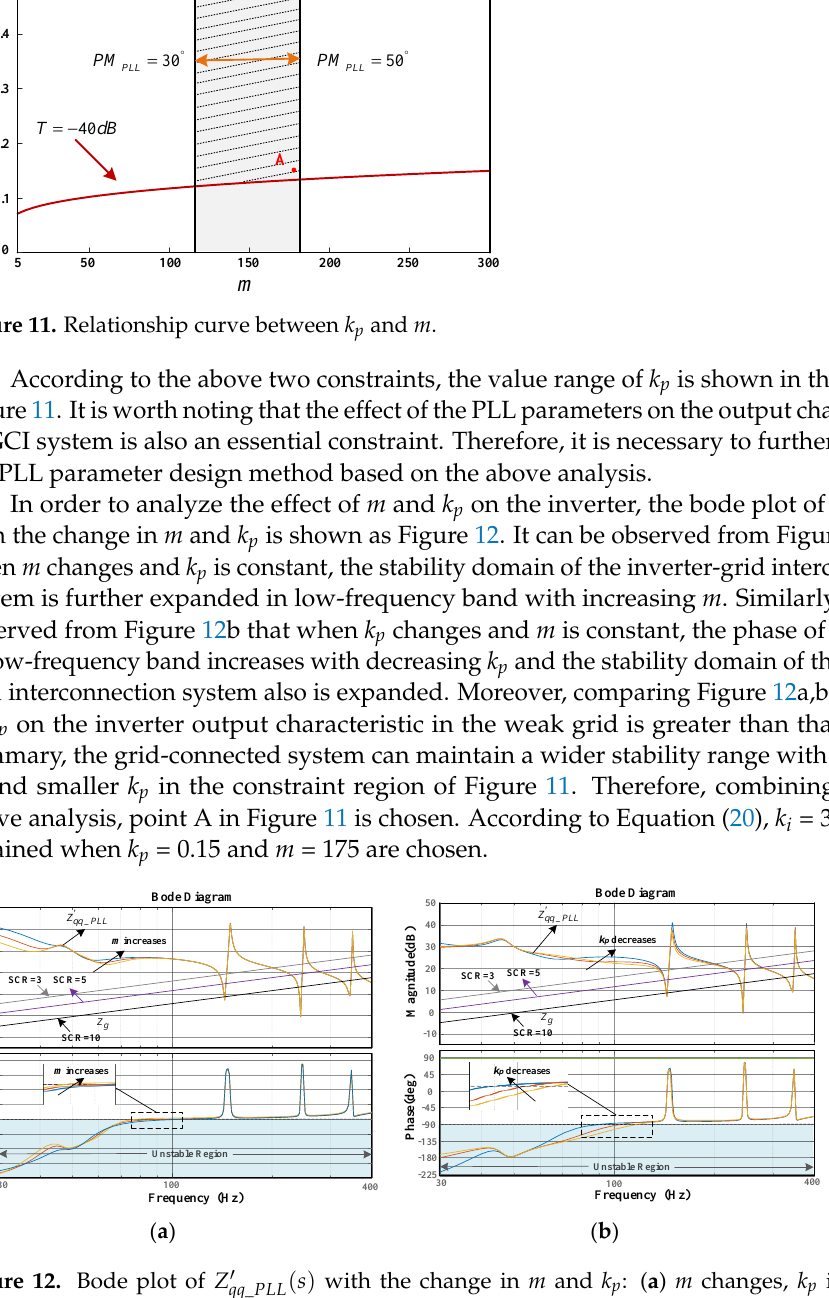
Figure 12. Bode plot of qq_ ( ) PLL Z s  with the change in m and k p : ( a ) m changes, k p is constant; ( b ) k p changes, m is constant.